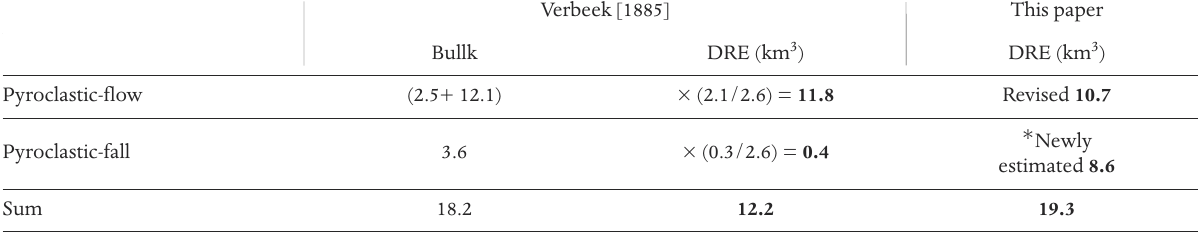
Table 4. Revised volume of the pyroclastic deposits on and around Krakatau Islands; ( ∗ ) analogical estimation in Section